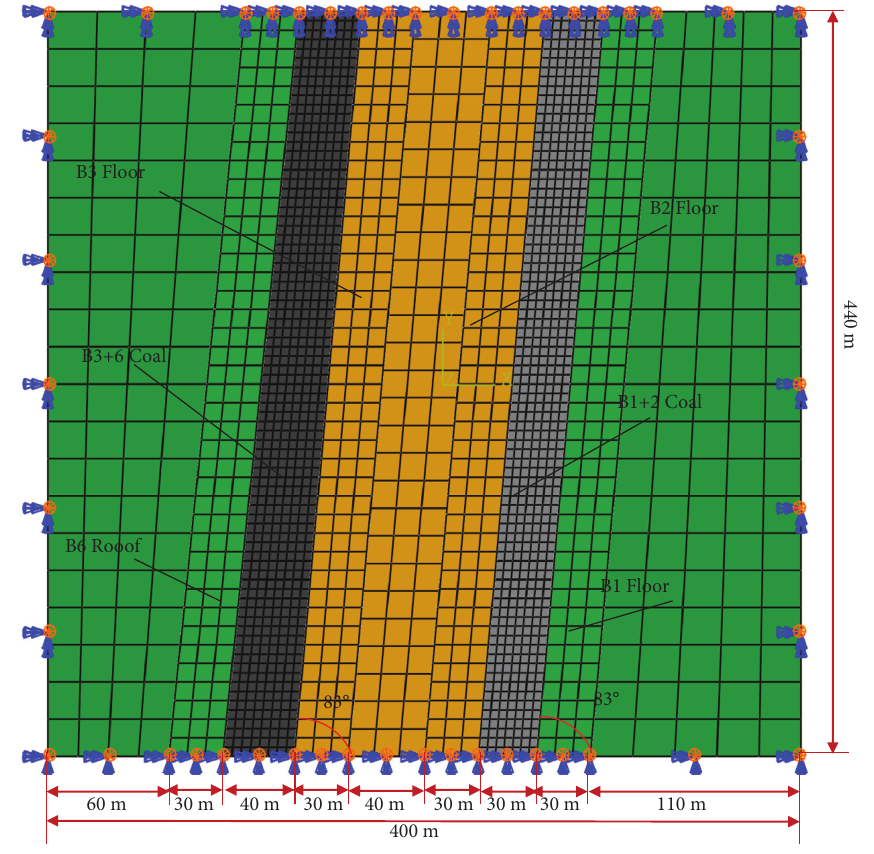
Figure 4: Numerical model diagram. Table 3: The parameters of numerical